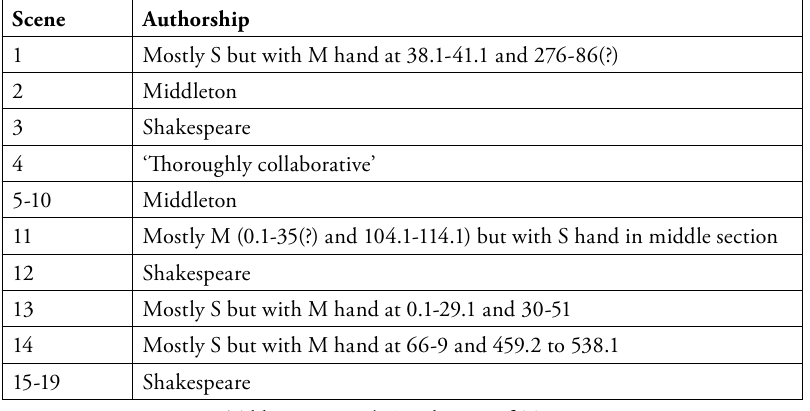
Table 1 – Jowett’s Attribution of